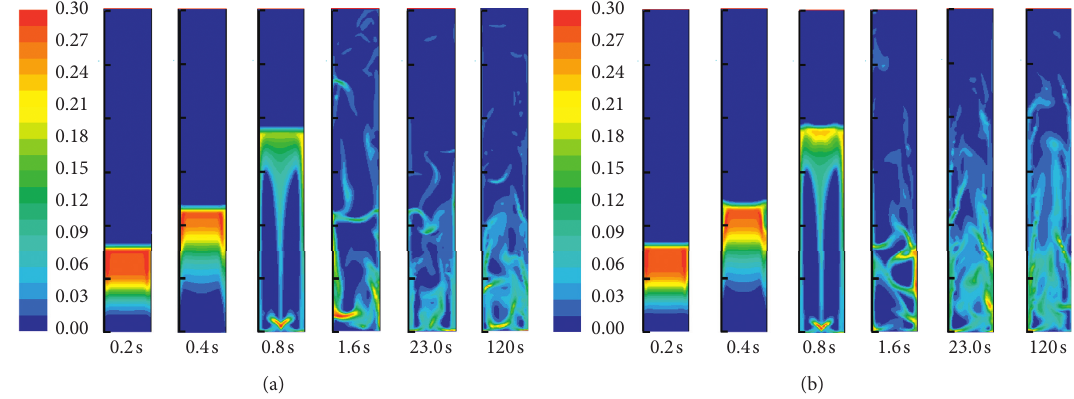
Figure 12: Volume fraction of dust: d � 0.20mm and ρ � 1100kg/m 3 . (a) u � 0.70 m/s. (b) u �